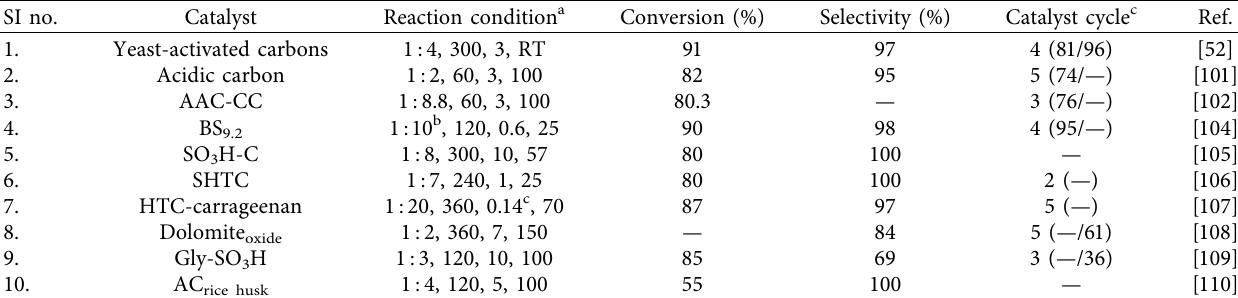
Table 3: Biomass-derived catalyst for solketal